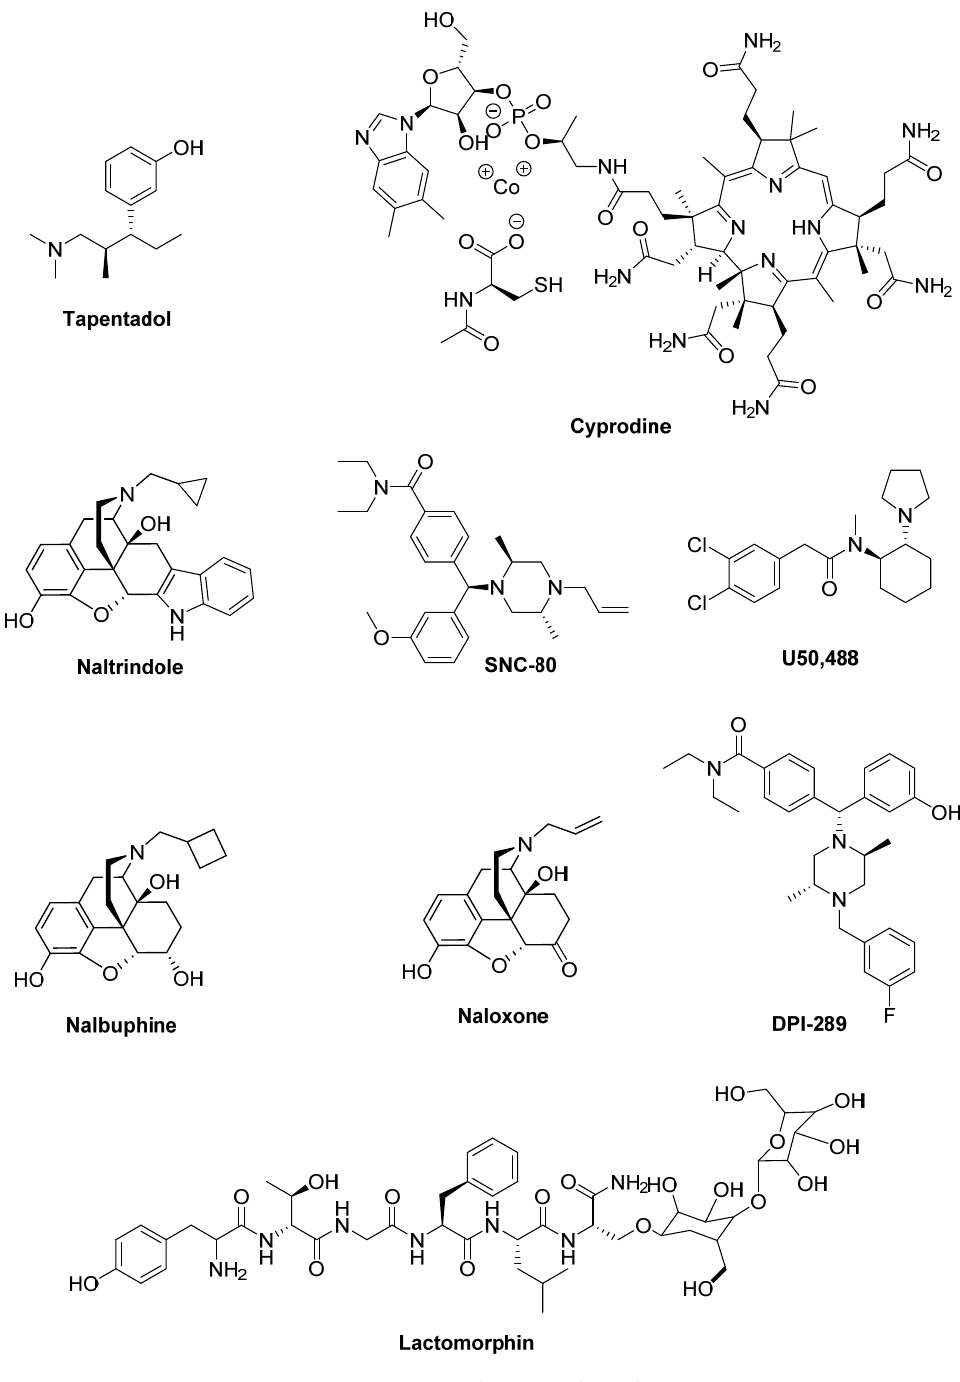
Figure 17. Opioid receptor ligands.